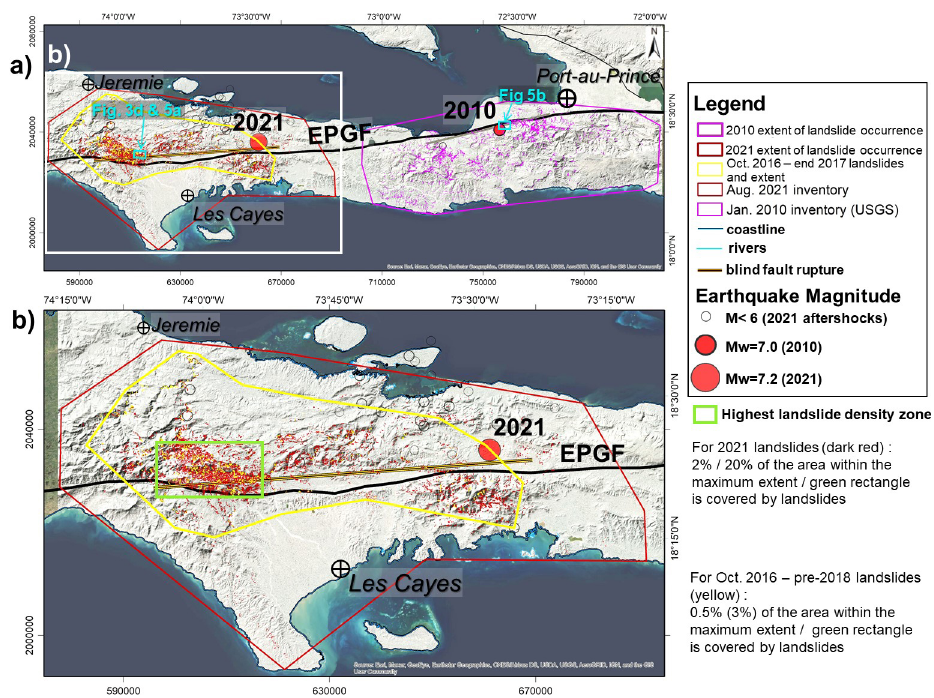
Figure 4. (a) Study region with areas affected by the two M w ≥ 7 events. Individual landslides triggered in 2010 (Harp et al., 2016, inventory) and our landslides mapped for the 2021 earthquake and October 2016 hurricane events are shown, respectively, as pink, dark-red, and yellow polygons. The maximum extent of landslides triggered in 2010, in 2021, and in 2016 is outlined, respectively, by the large pink, dark-red, and yellow polygons. (b) Focus on the region hit by the August 2021 earthquake, with 7091 landslide locations. Map background © ESRI.